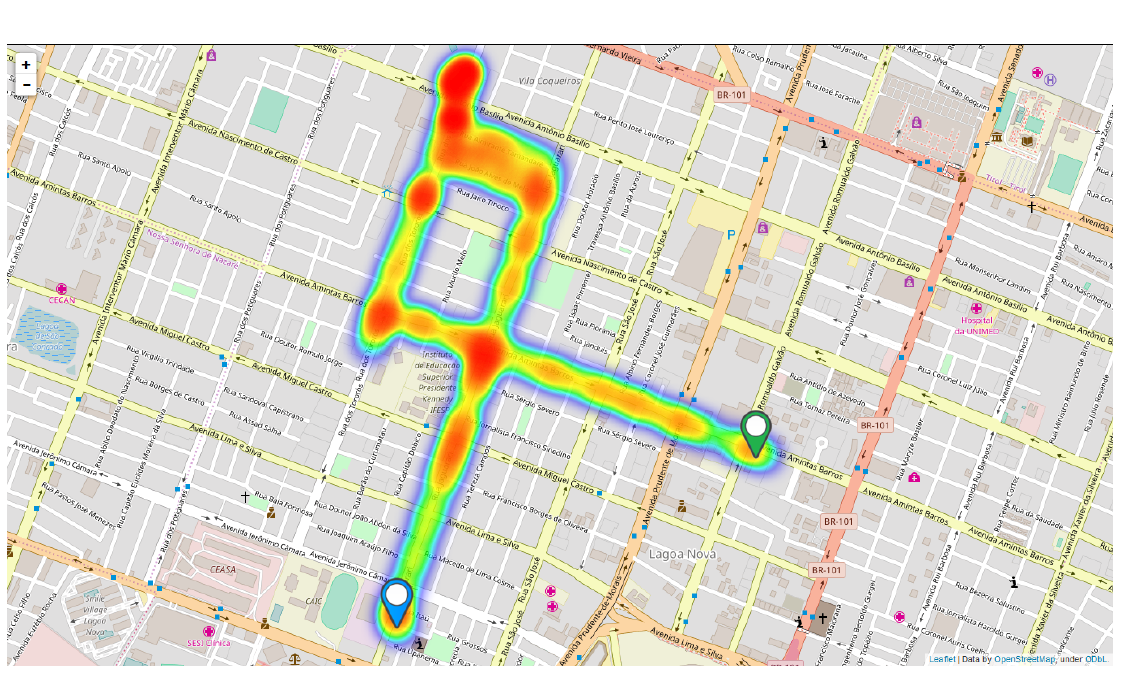
Figure 4. Toyota Etios route pollutant emission heat